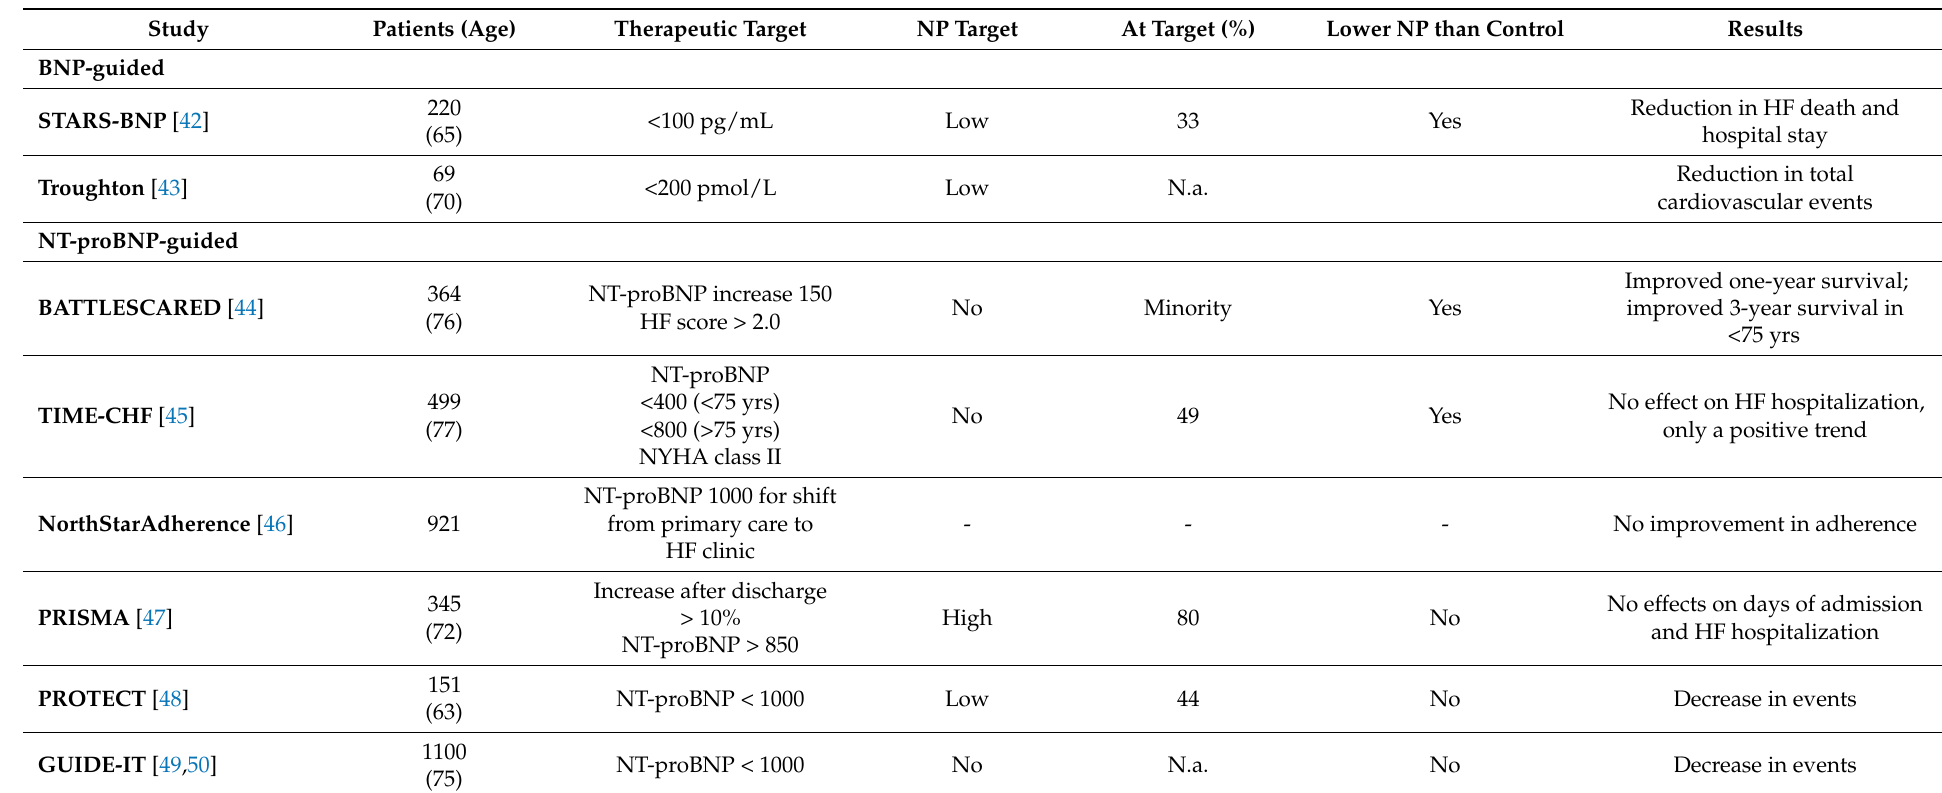
Table 1. The main studies evaluating the usefulness of natriuretic peptides to guide heart failure